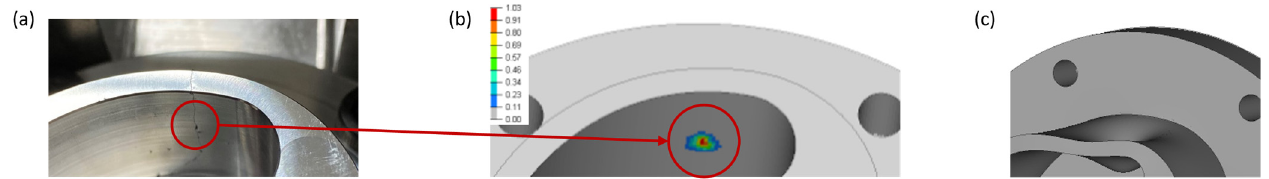
Figure 12. ( a ) Failed C-specimen after the fatigue test; ( b ) damage fraction contour of the FEM model; and ( c ) deformation of the FEM model.